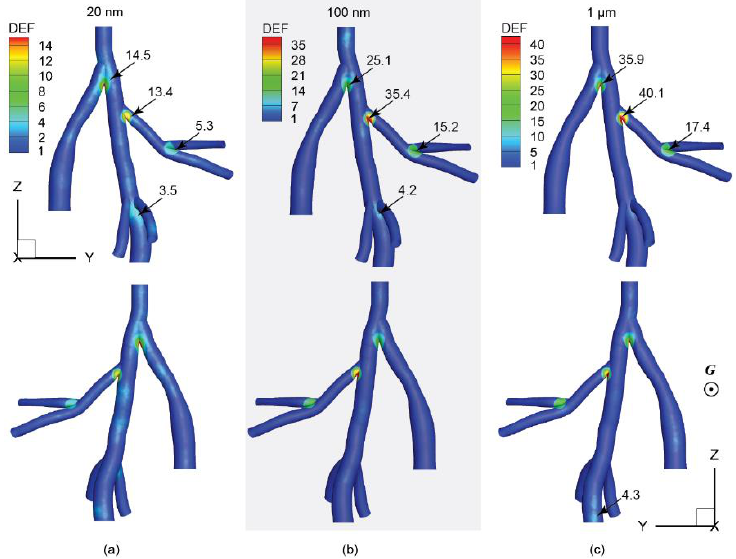
Figure 6. Deposition enhancement factors (DEFs) for the rat lung airway with particle sizes of ( a ) 20 nm, ( b ) 100 nm, and ( c ) 1 µm.